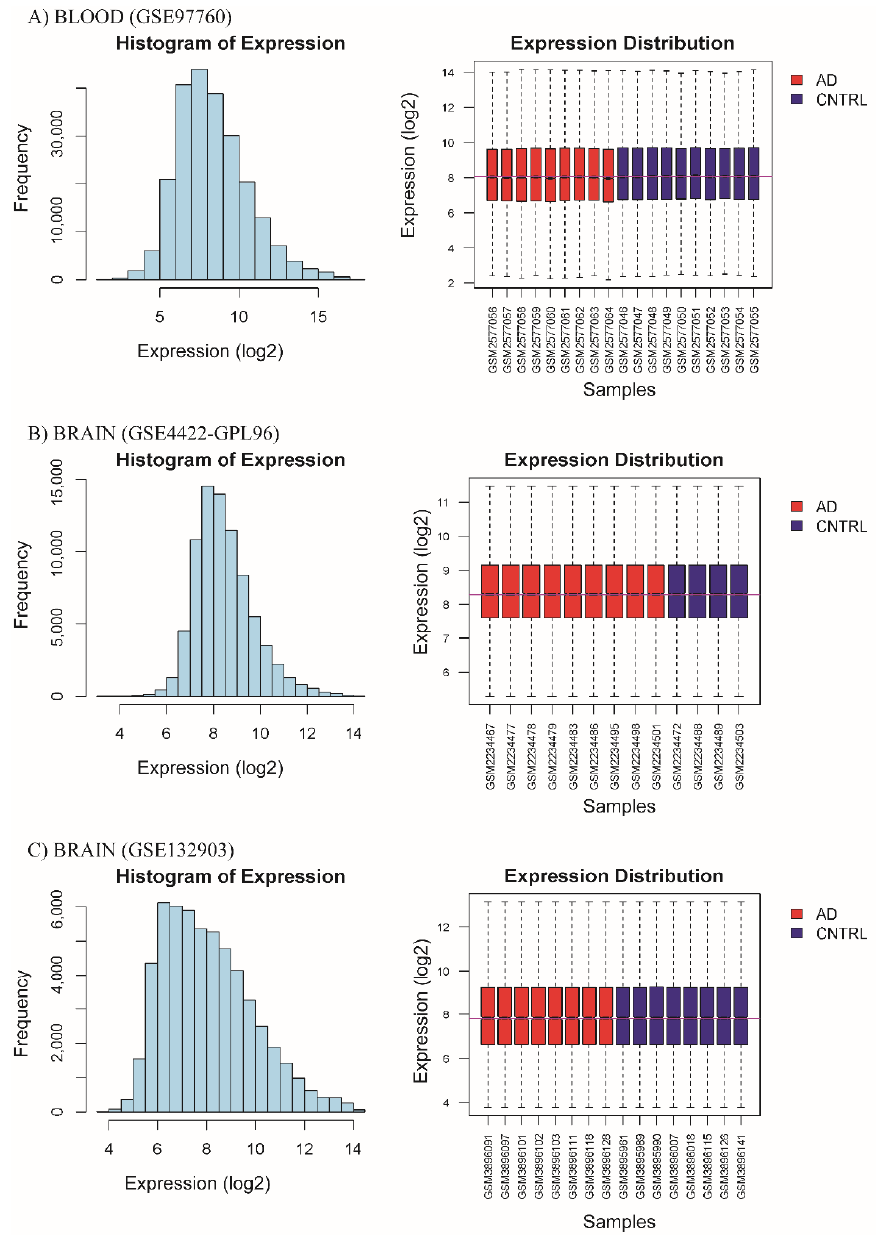
Figure 2. Homogenization of data, distribution histogram of logarithmic-scale expression after processing data, and Tukey diagrams with expression value distribution in a logarithmic scale of each subject in both groups (CNTL and AD). Data of ( A ) blood tissue from database GSE97760, ( B ) brain tissue from database GSE84422-GPL96, and ( C ) brain tissue from database